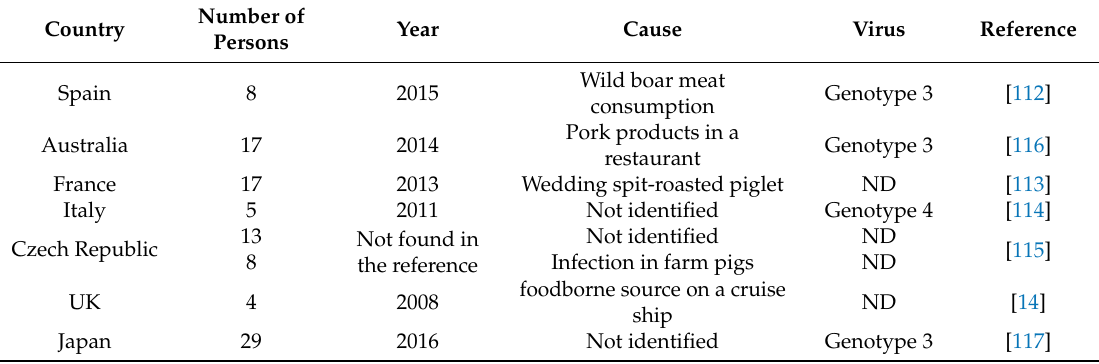
Table 6. List of HEV outbreaks for which peer-reviewed data are